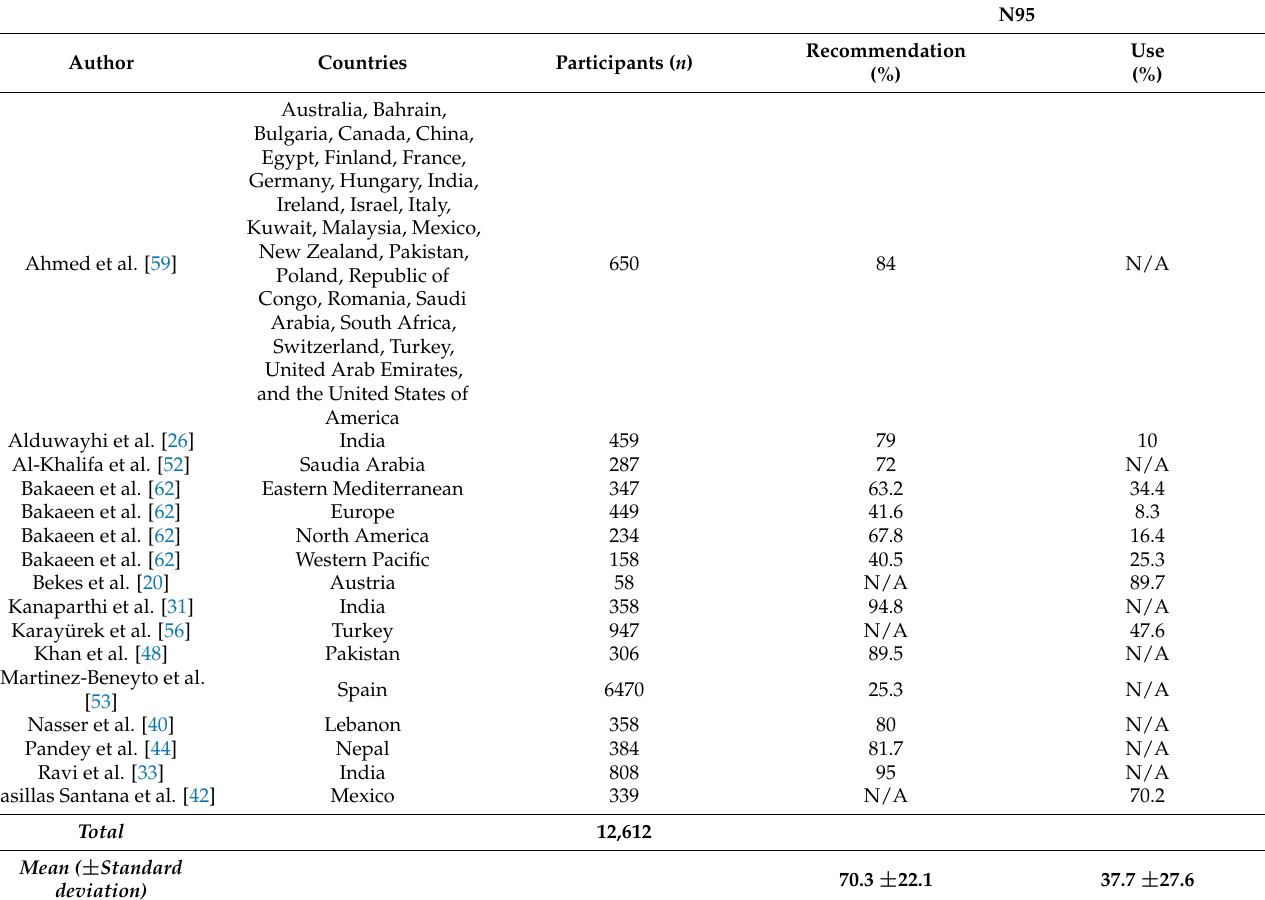
Table 6. Recommendation and use of N95 masks expressed as percentage of dentists.